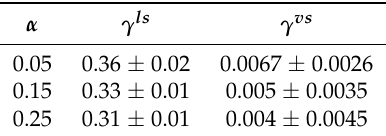
Table 2. Surface tensions for the liquid/solid and vapor/solid interfaces. Values are presented for three interaction parameters α in the Lennard-Jones potential used in the computations. The surface tensions were computed via the excess of the tangential pressure tensor (see Equation